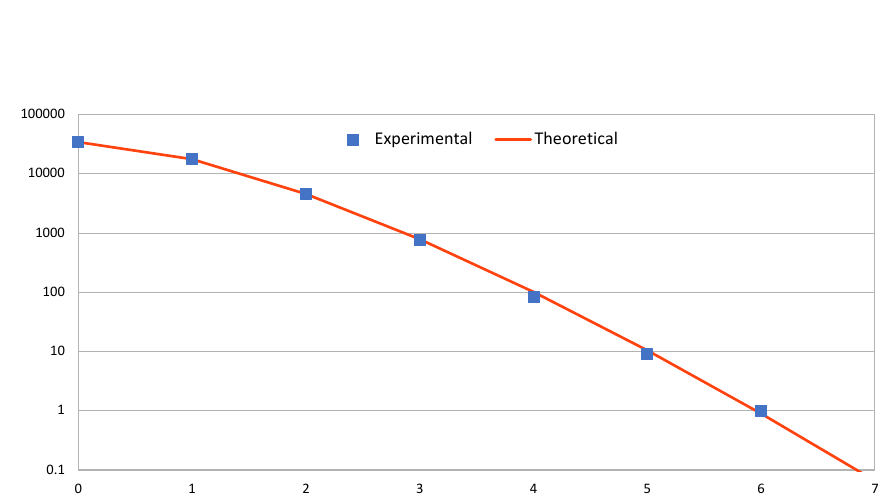
Figure 13: Experimental and theoretical distributions of N( a, b ), corresponding to Table 10.